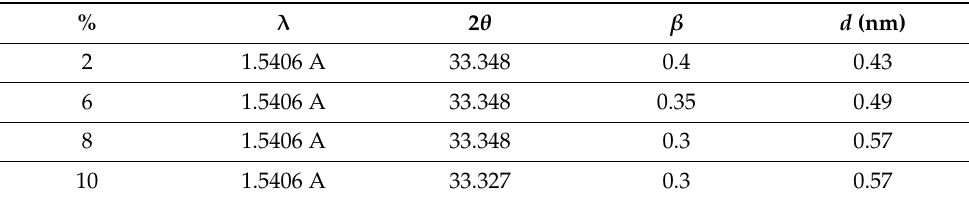
Table 2. The quantitative analysis of the YAG samples doped with different concentrations of eu- ropium.